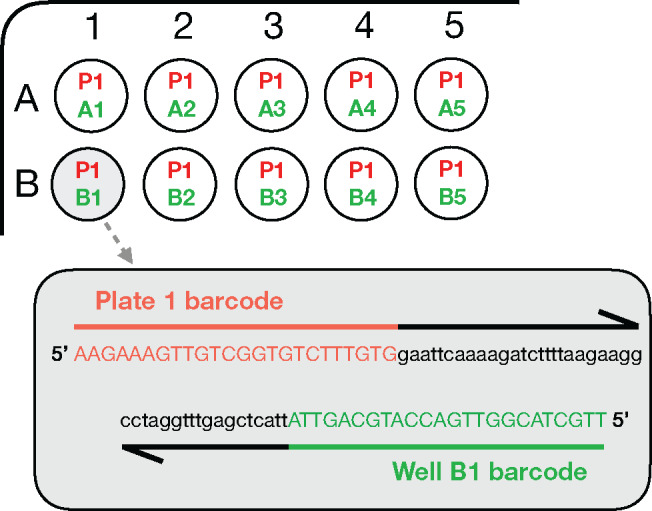
Allocation of primer pairs to enable the identification of individual wells from highly multiplexed samples, using well B1 from plate 1 as an example. Each well is allocated a forward primer, identifying the source plate, and a reverse primer, identifying the well. This enables the accurate identification of each individual well by data analysis after sequencing.